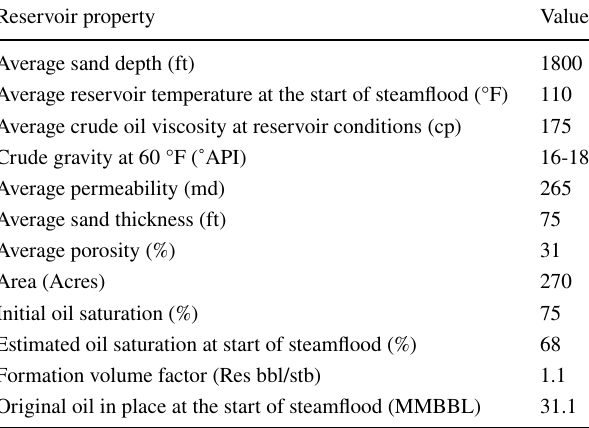
Table 1 Cruse ‘E’ (IADB) expansion steamflood summary of reser- voir (adapted from SPE 89411—Ramlal